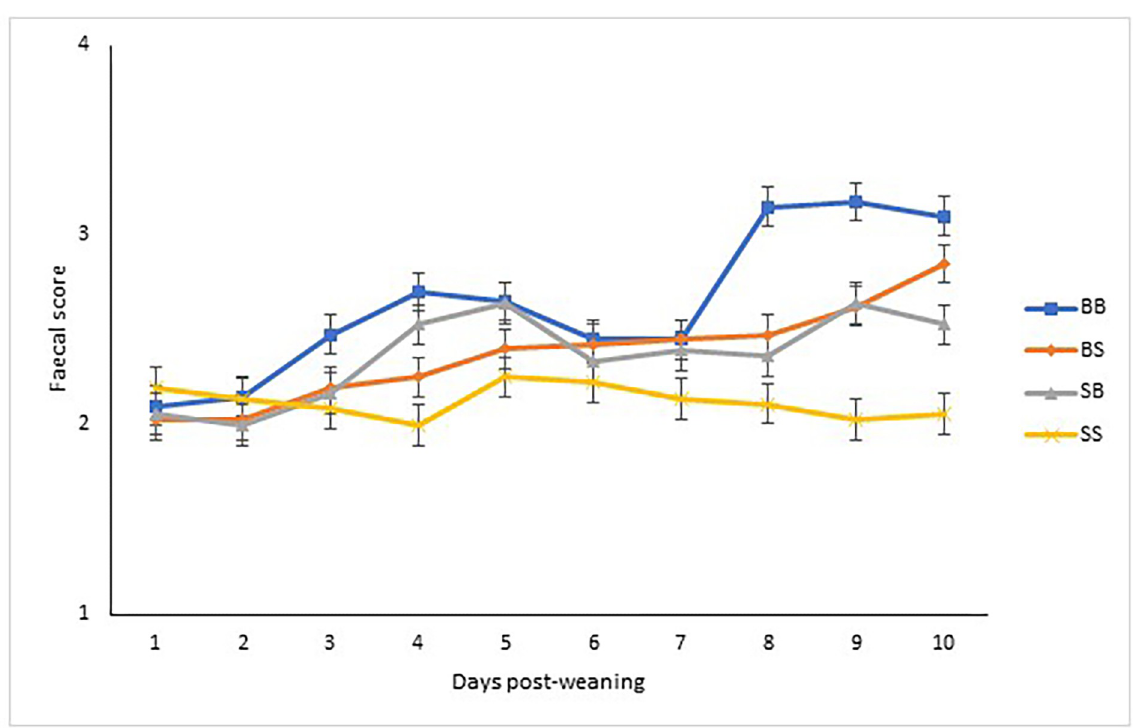
Fig 2. Effect of supplementation of CH-YBG during gestation/lactation and/or post-weaning on faecal scores from day 0–9 post-weaning. BB basal sow, basal pig; BS basal sow, supplemented pig; SB supplemented sow, basal pig; SS supplemented sow, supplemented pig. Values are means, with their standard errors represented by vertical bars. Scale from 1 to 5: 1 = hard, firm faeces; 2 = slightly soft faeces; 3 = soft, partially formed faeces; 4 = loose, semi-liquid faeces; and 5 = watery, mucous-like faeces [19]. Time (p < 0.001), lactation diet (p < 0.001), post-weaning diet (p < 0.001), lactation diet × post-weaning diet (p > 0.10), lactation diet × post-weaning diet × time (p < 0.001).